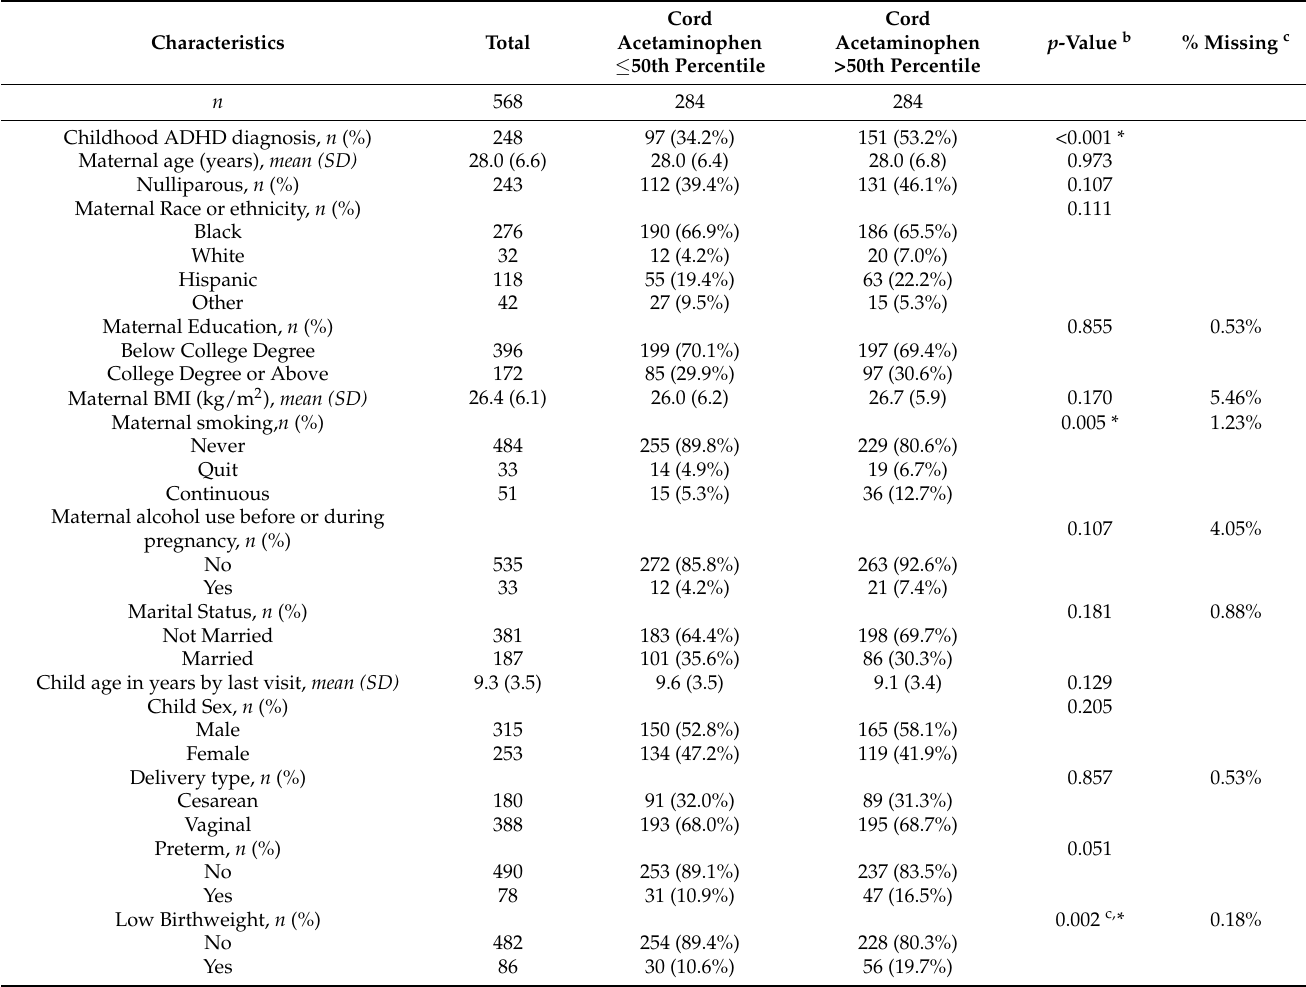
Table 1. Maternal and child characteristics by cord plasma acetaminophen ≤ 50th percentile vs. >50th percentile a .